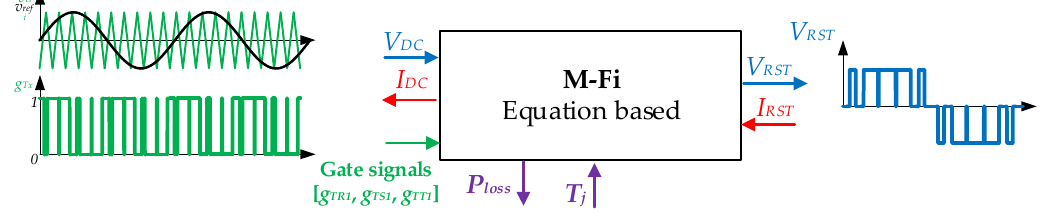
Figure 11. M-Fi model block. ( Left ) DC voltage and current, and the gate input PWM signal. ( Right ) AC voltage and currents. On the lower side, the thermal and power variables are shown.